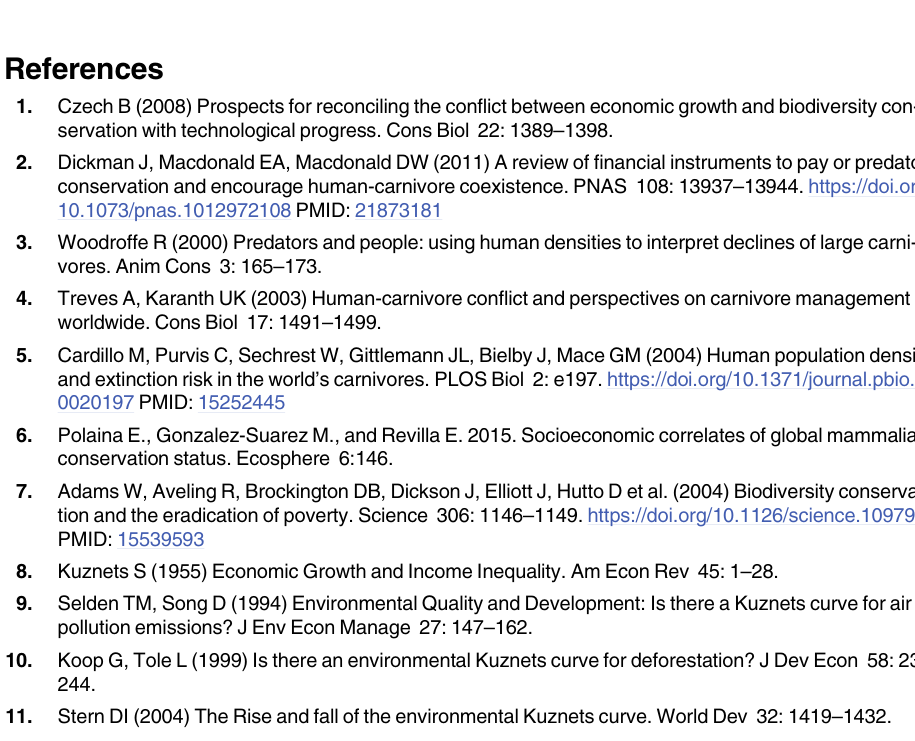
S1 Table. Data used in this